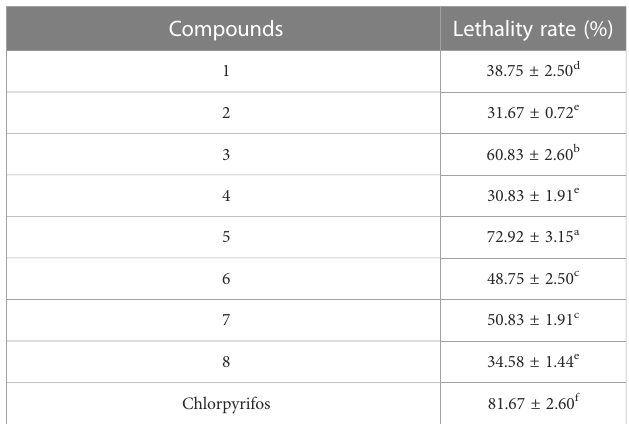
TABLE 3 The lethality of eight compounds to C.